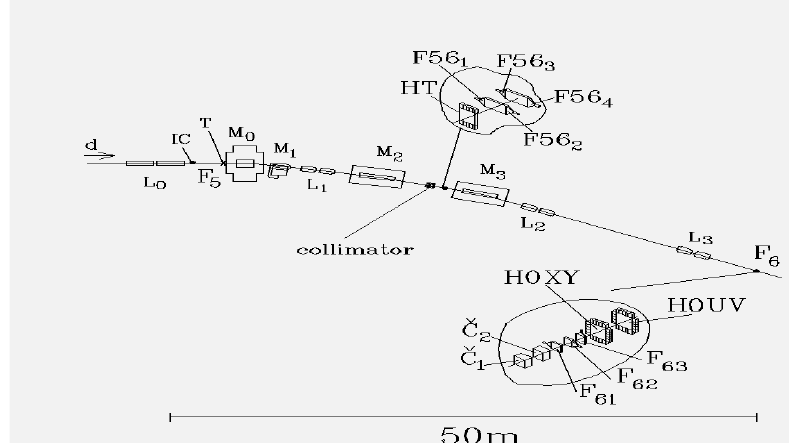
Figure 5. The scheme of measuring T 20 on channel 4B of the LHEP accelerator complex JINR. The target is marked with T, IC-ionization chamber for beam monitoring, M i - deflecting magnets, L i - doublets of quadrupole lenses, F ij -scintillation counters, ˇC i -Cherenkov threshold counters and H0XY, H0UV - scintillation